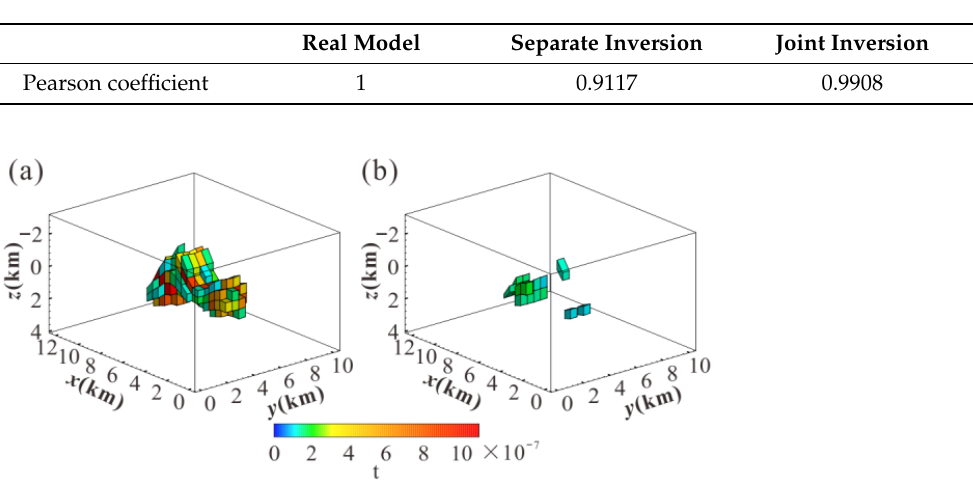
Figure 19. Cross-gradient of inversion result. ( a ) Separate result; ( b ) joint result. Table 8. RMSm of inversion results.